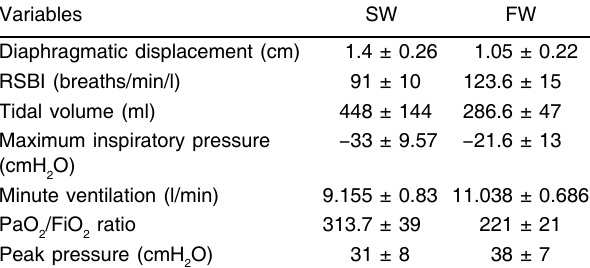
Table 9 Comparison of the different parameters between groups with successful weaning and those with failed weaning